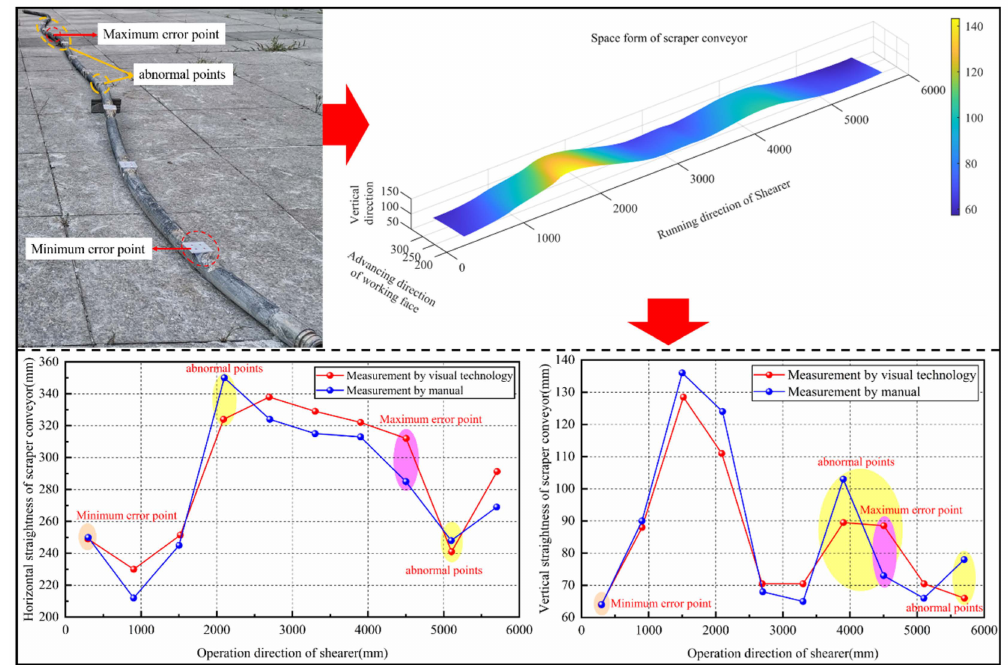
Figure 6. Scraper conveyor straightness measurement